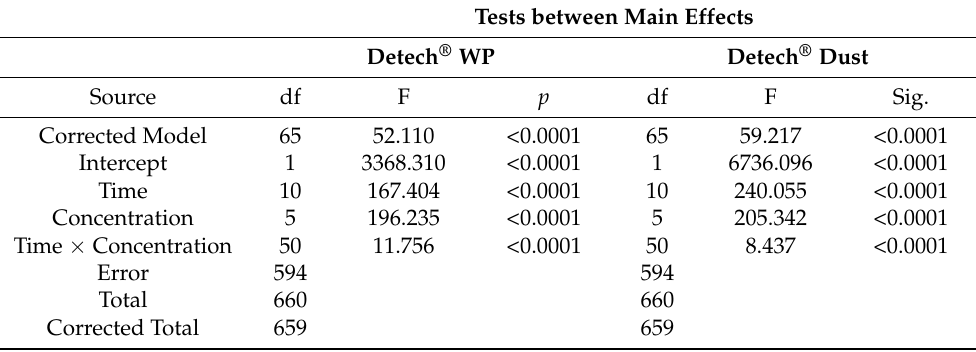
Table 1. ANOVA parameters for main effects and associated interactions for mortality of Tyrophagus putrescentiae adults exposed to DE formulations of Detech ® WP 95 and Detech ® Dust. Tests between Main Effects